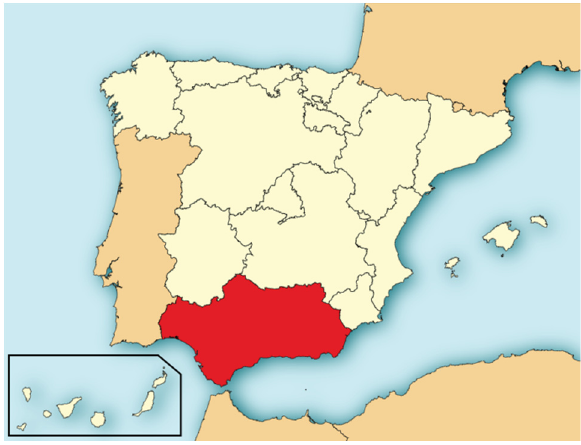
Figure 2. Location of Andalusia highlighted in Southern Spain [11].